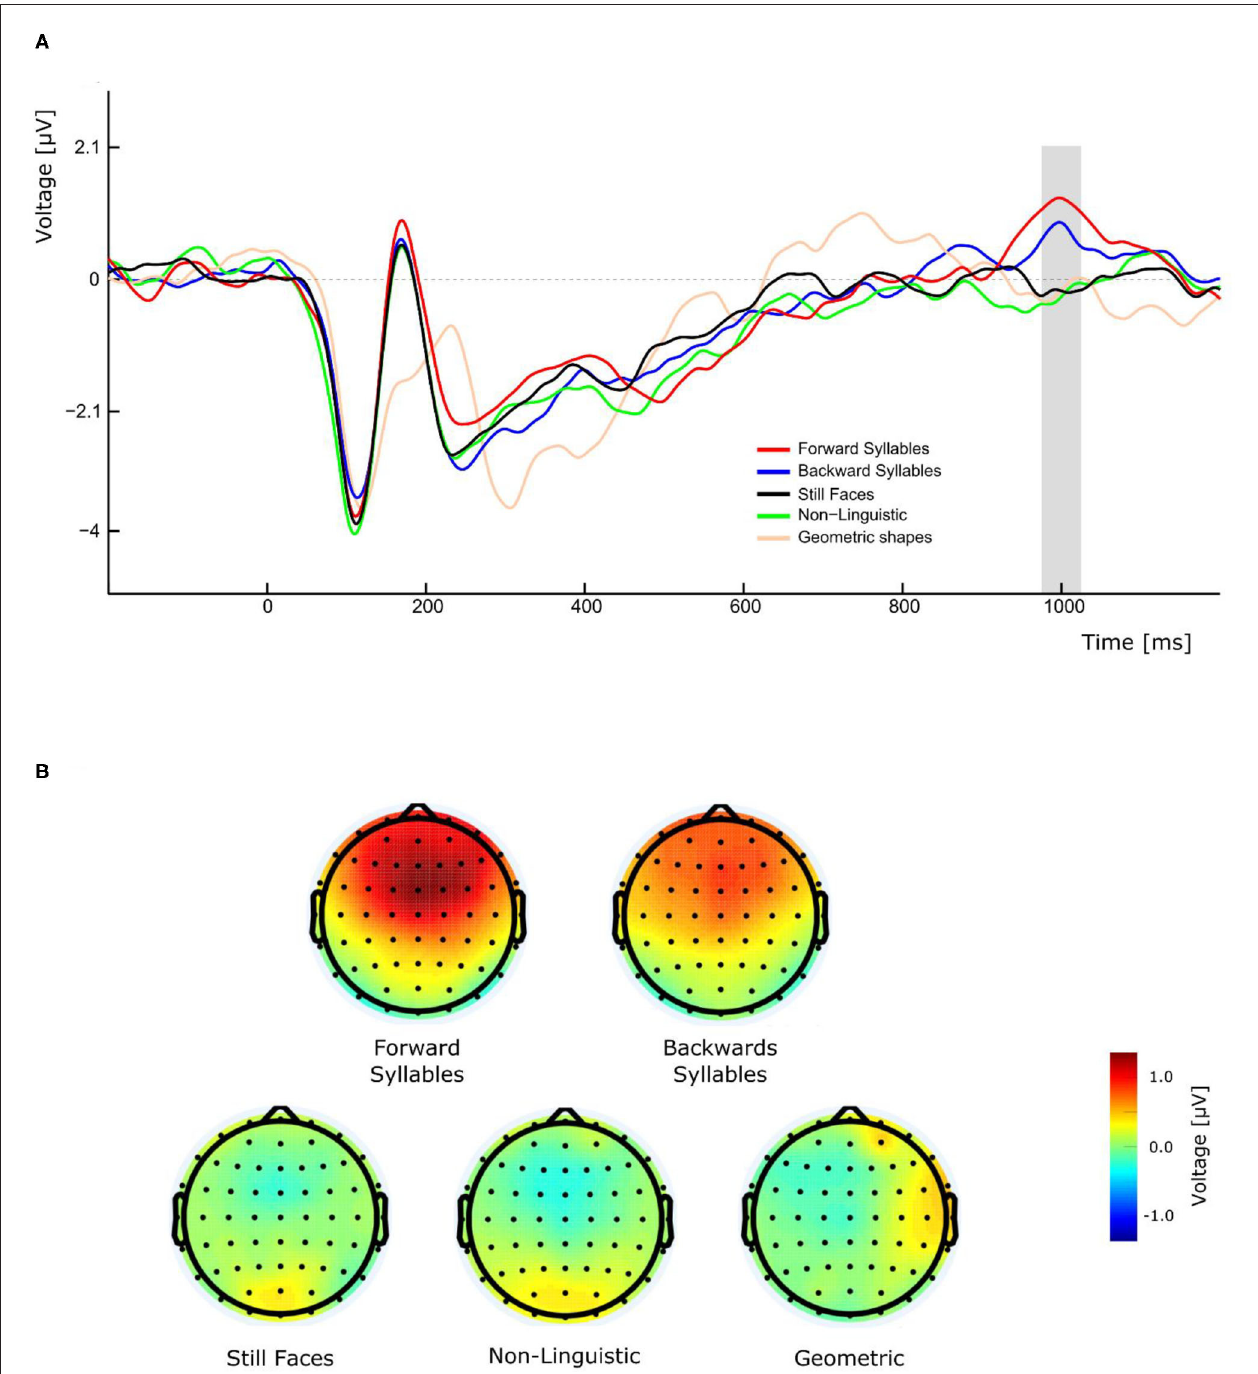
FIGURE 3 | Effect of conditions on P1000 component in experiment 1. (A) The gray bar represents the time window in which significant differences in amplitude were found. (B) Forward and backward syllables (top maps) and non-syllabic conditions (bottom maps) showed different topographic representations.